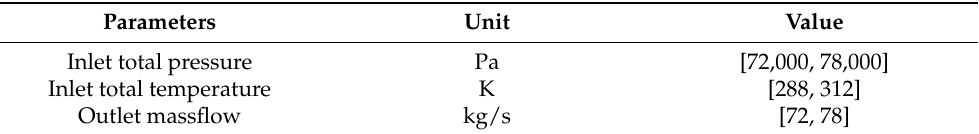
Table 2. RANGES OF SAMPLING.